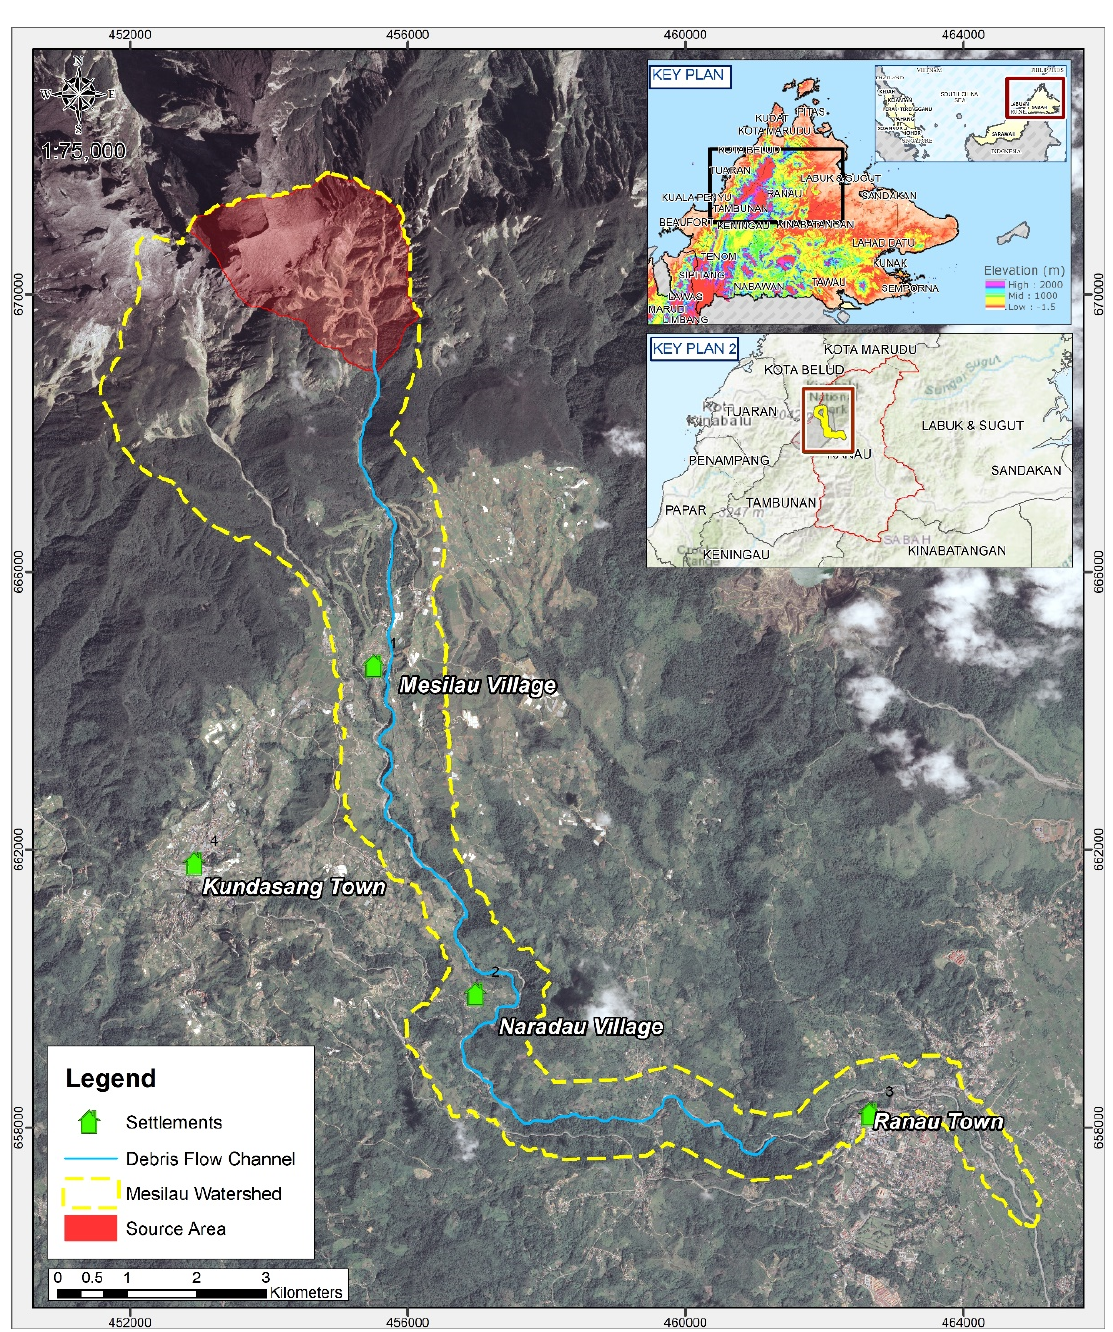
Figure 4. The overall debris flow of the study area at the Mesilau watershed, Kundasang, Sabah.